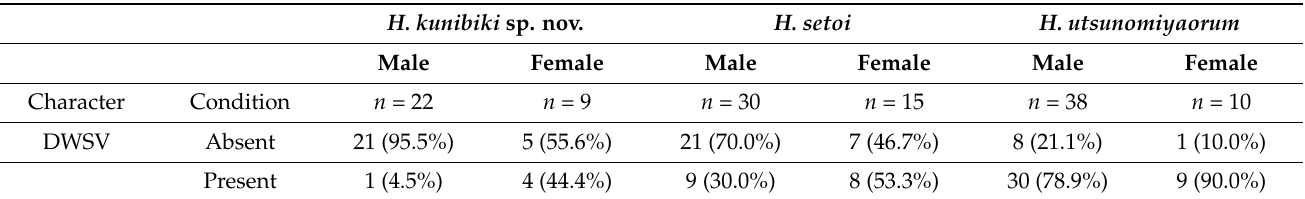
Table 2. Characteristics of skin markings among the three species of Hynobius . The values indicate the number of individuals exhibiting that characteristic with percentages related to each condition in parentheses. See Materials and Methods section for definitions of morphological